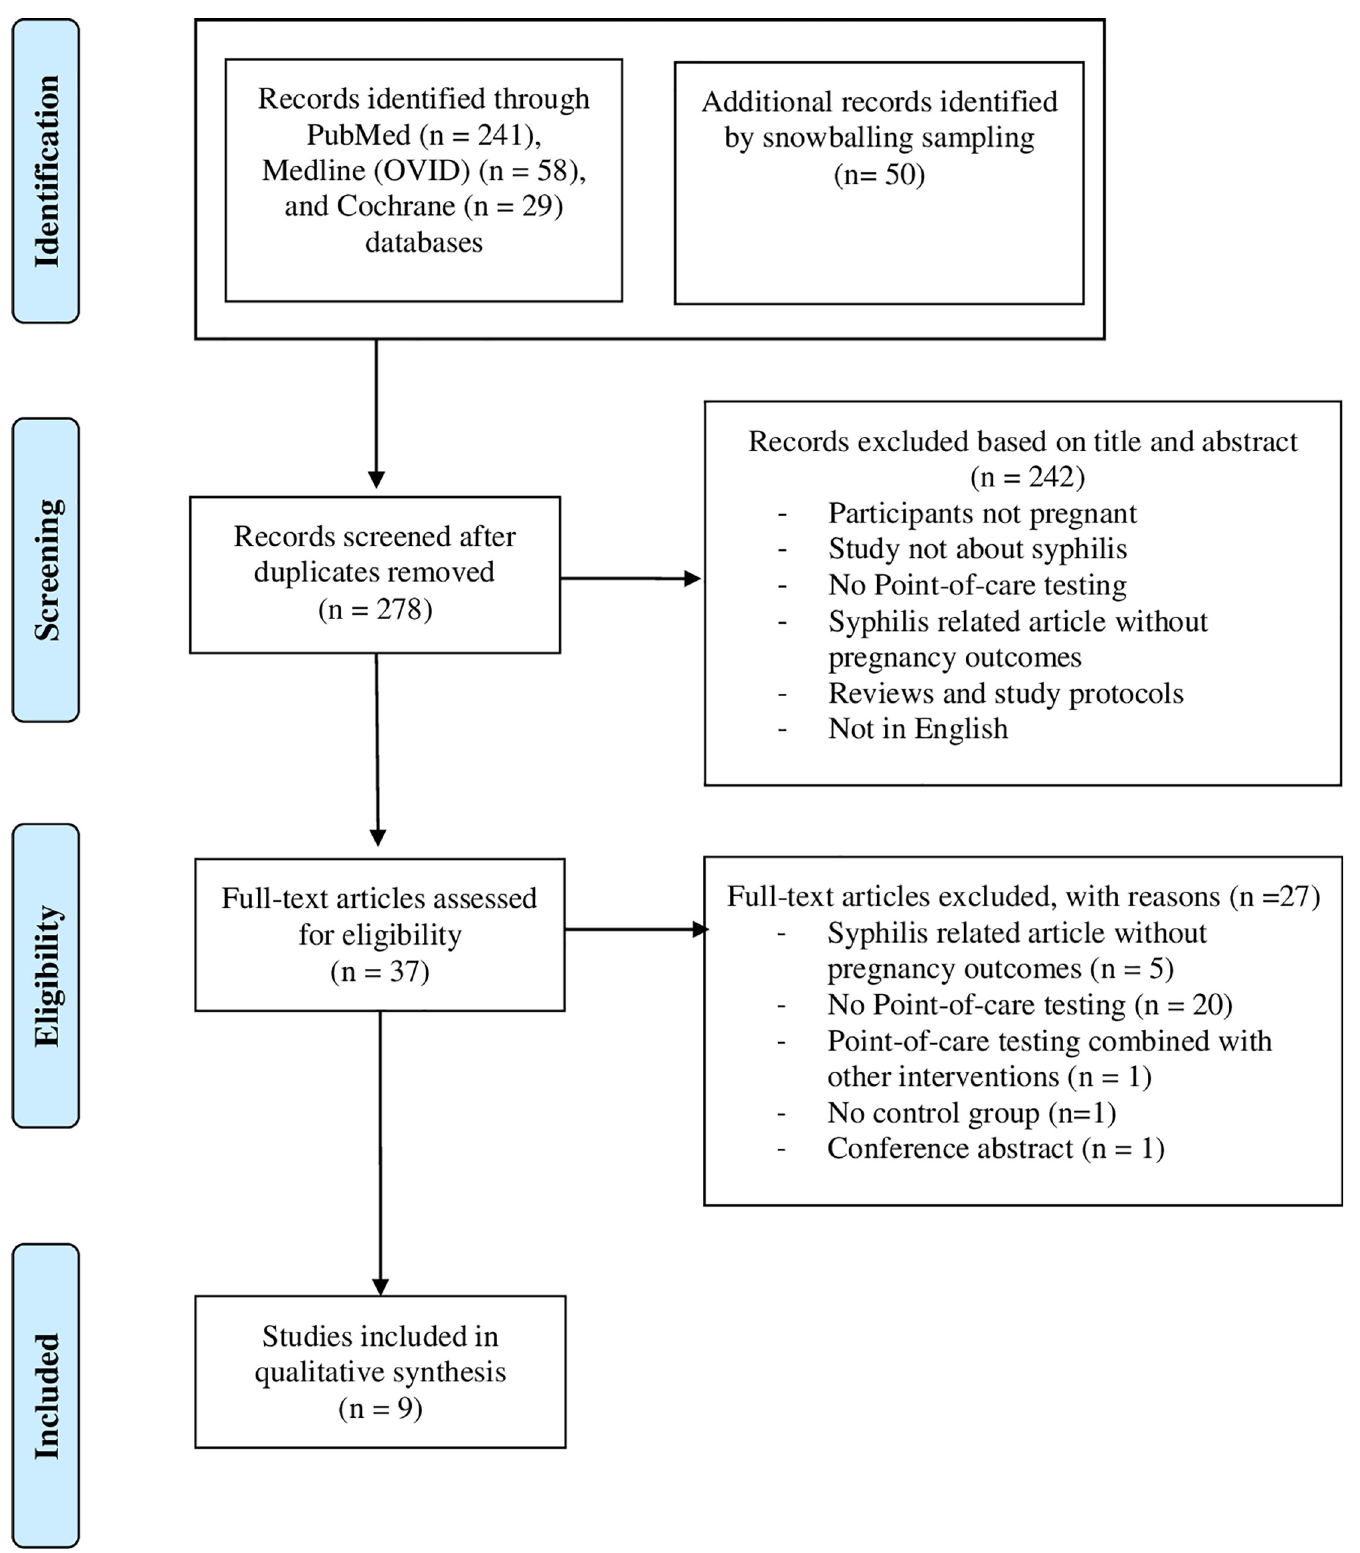
Fig 1. PRISMA based flow diagram displaying the study selection.